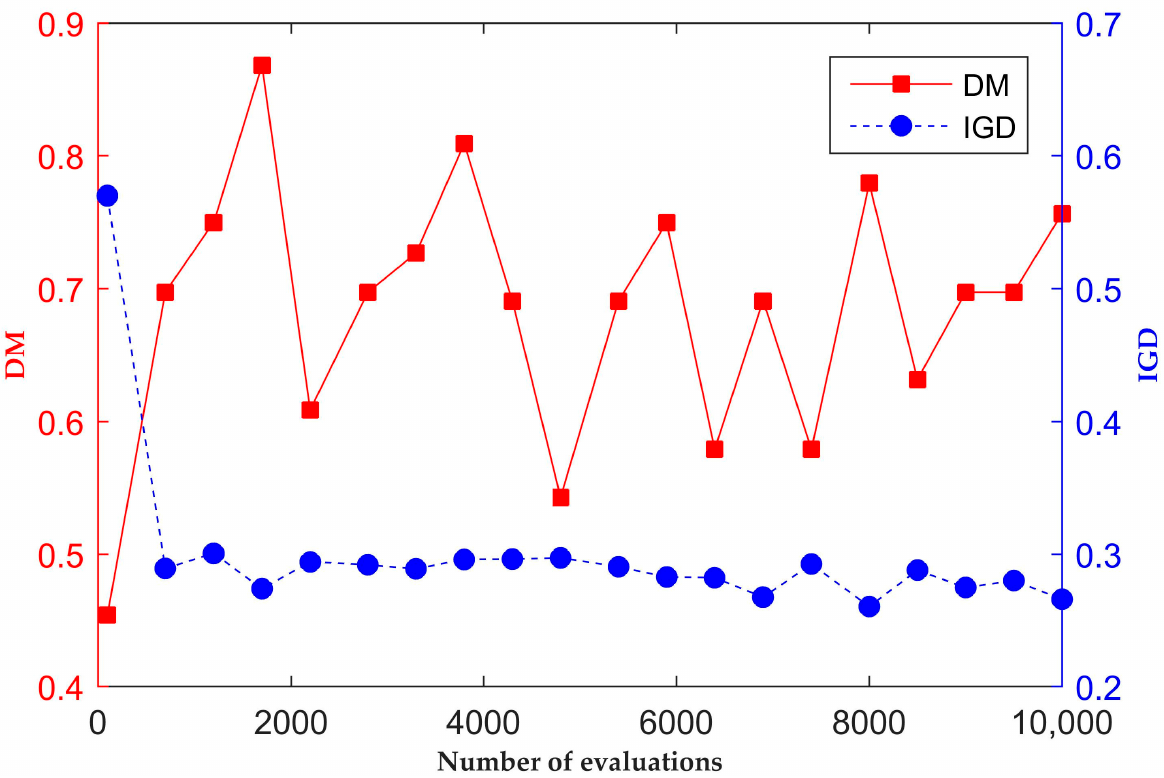
Figure 8. The DM and IGD indicator of optimization results.